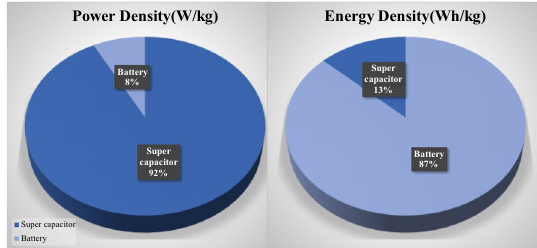
Fig. 3 Comparison diagram of characteristics of storage battery and super